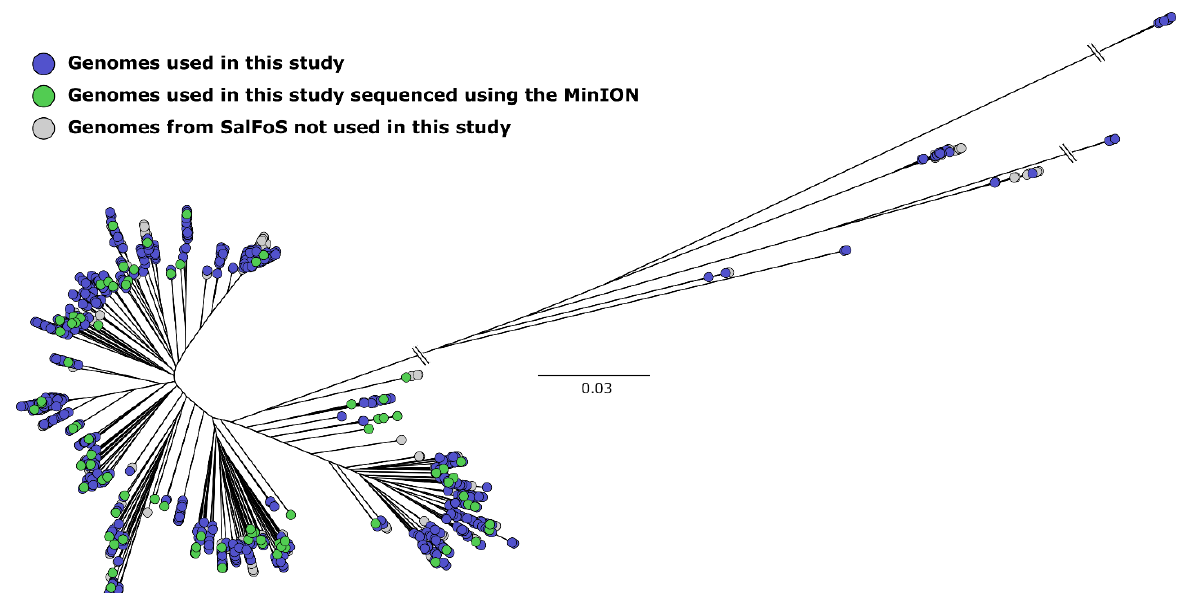
Figure 4. Unrooted maximum likelihood tree of 2544 S. enterica genomes based on 173,657 single nucleotide polymorphisms (SNPs). Genomes were assembled using SPAdes. Isolates used are labelled in green and blue. Green nodes were isolates sequenced using Oxford Nanopore.